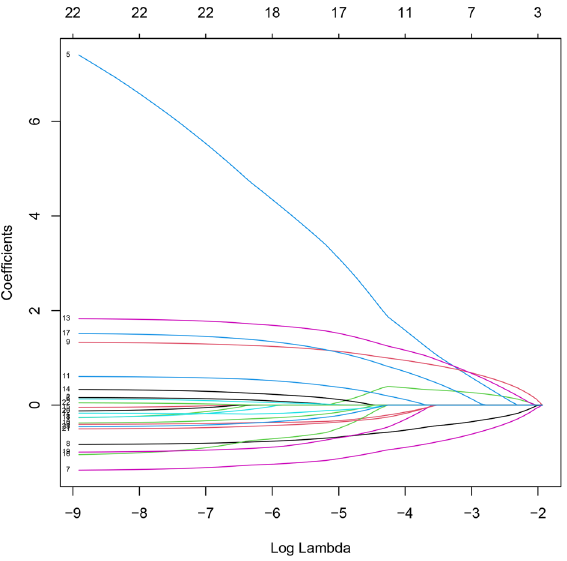
Figure 2. The features with nonzero coefficients were selected by optimal lambda.